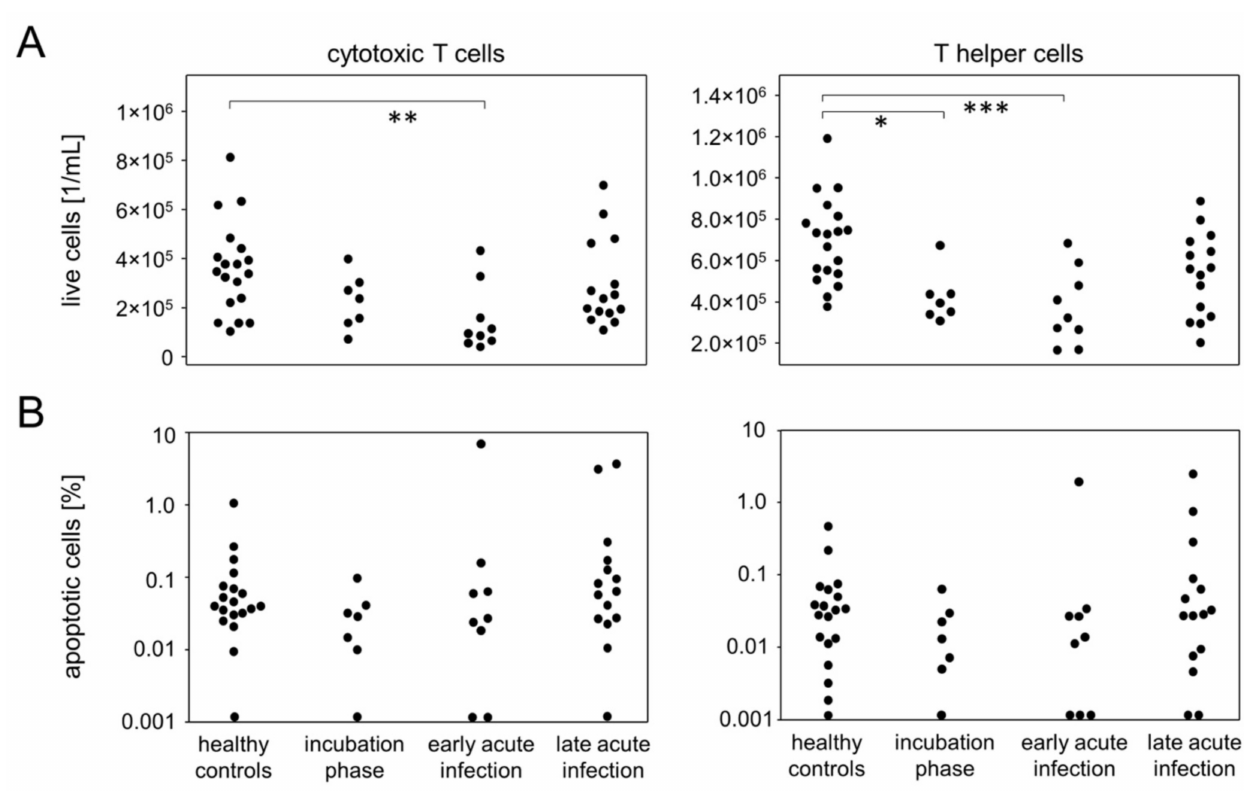
Figure 7. Mild-to-moderate COVID-19 induced apoptosis-independent CD4 + and CD8 + T lymphope- nia at the incubation and early infection phases. ( A ) Total cell numbers of cytotoxic T cells (left) and T helper cells (right). ( B ) Quantitative data of apoptotic cell proportions among cytotoxic T cells (left) and T helper cells (right). * p < 0.05; ** p < 0.01; *** p < 0.001; Tukey-Kramer